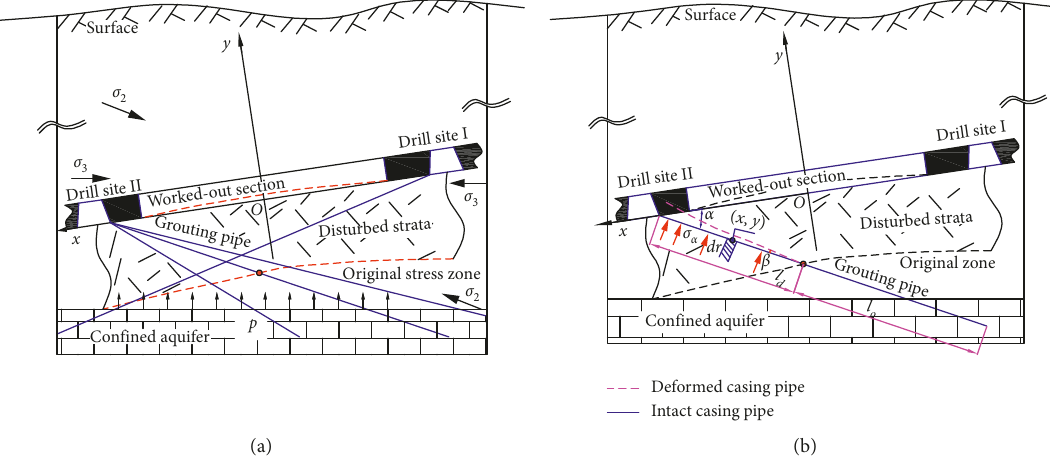
Figure 10: Sketch of (a) grouting casing pipes layout in Zhaogu No. 2 coal mine and (b) force analysis of a grouting casing